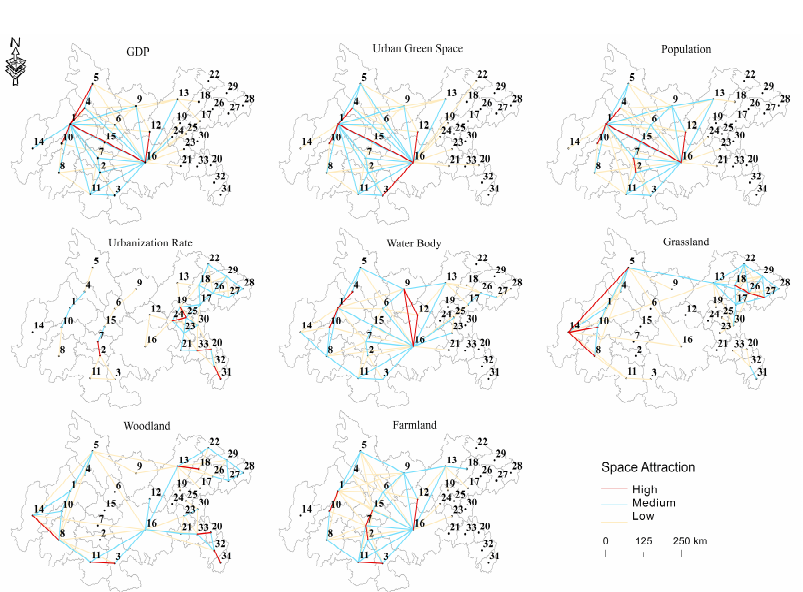
Figure 6. Space attraction between cities. Only cities with the top 10% attraction are shown on the map. High: top 1%; medium: top 1%–top 5%; low: top 5%–top 10%. (For more details, please refer to Tables A1 and A2).